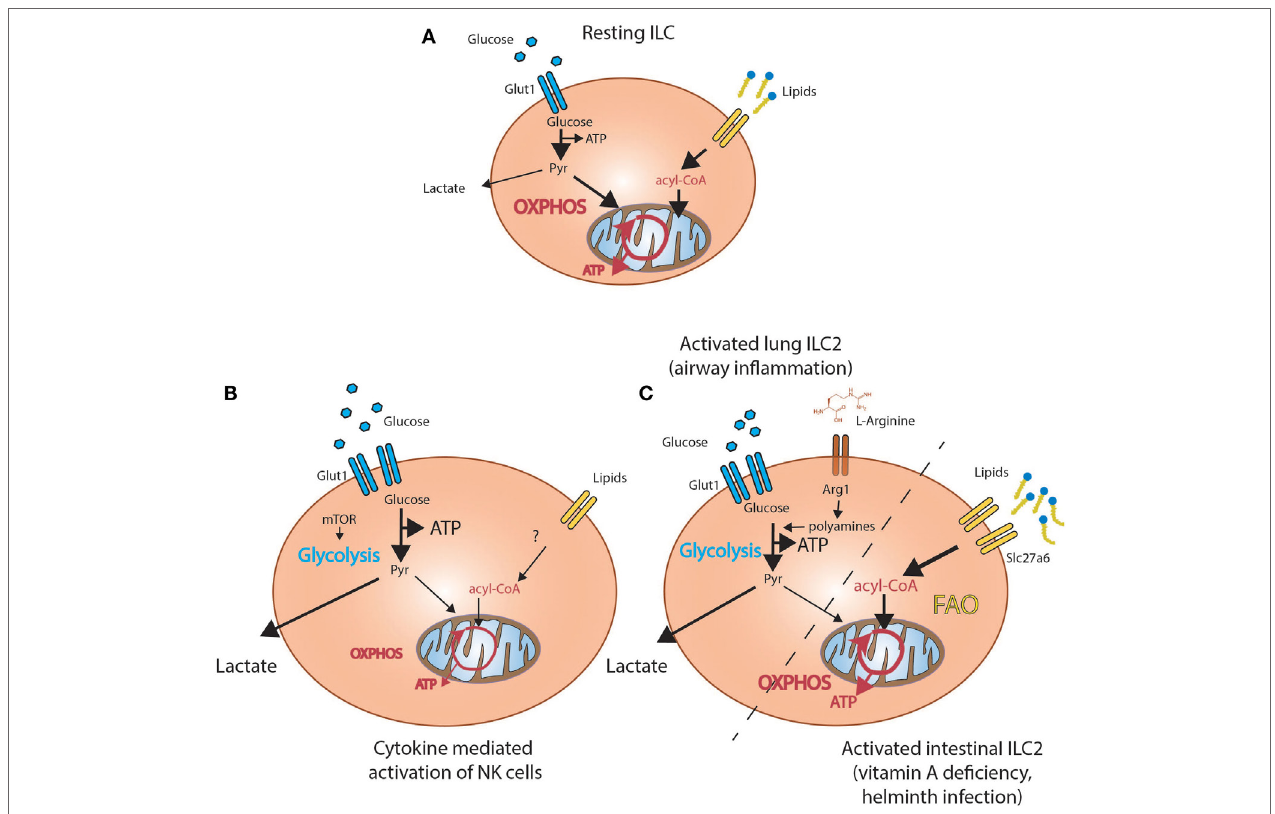
FigUre 2 | Metabolic programs active in innate lymphoid cells (ILC). (A) Resting ILC predominately rely on oxidative phosphorylation (OXPHOS) and take up lipids from the environment. (B) Activation of lung ILC2 in the context of airway inflammation (left side) results in increased glycolysis driven by conversion of arginine by Arginase-1 (Arg1) into polyamines. Activation of intestinal ILC2 in the context of helminth infections or vitamin A deficiency (right side) increases uptake of lipids from the environment and results in increased fatty acid oxidation (FAO)-dependent oxidative phosphorylation (OXPHOS). (c) Cytokine-mediated activation of NK cells results in increased uptake of glucose and increased mammalian target of rapamycin (mTOR)-dependent